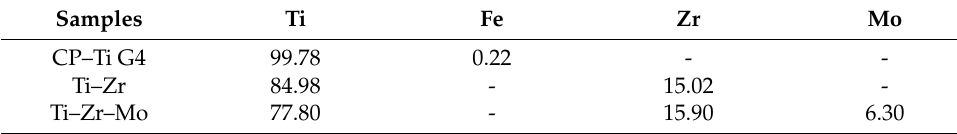
Table 1. Chemical analysis of samples content (wt.%).